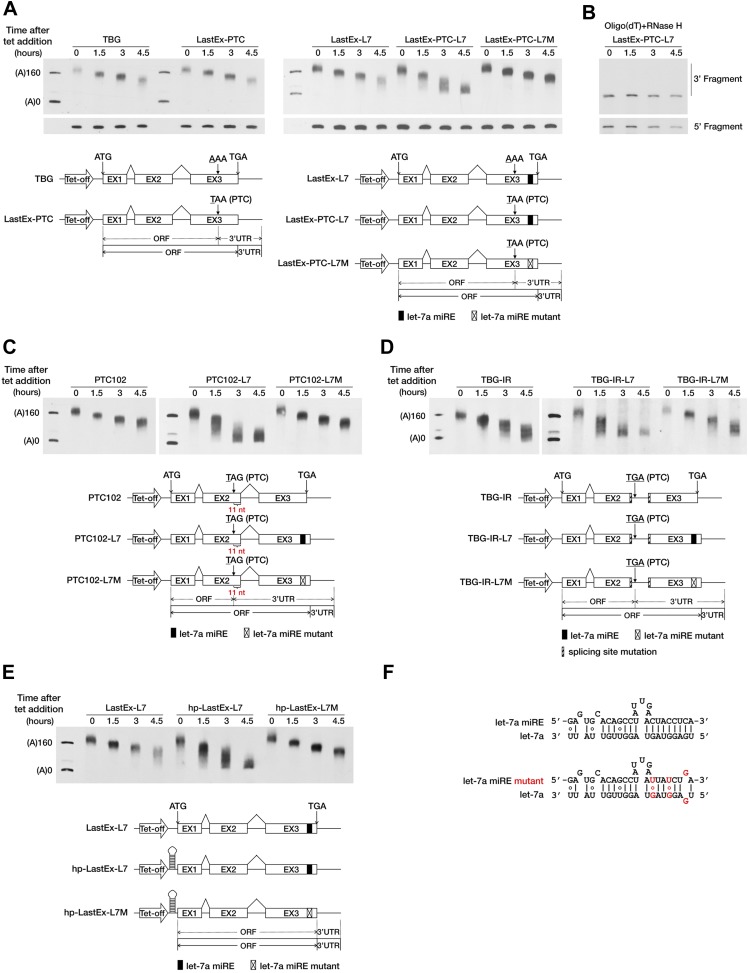
A PTC potentiates rapid miRNA-mediated deadenylation of nonsense mRNAs.(A) The influence of a PTC on BG mRNAs with or without a downstream miRE. Cytoplasmic RNA was collected at the indicated times after transcriptional arrest by adding tetracycline (tet). The RNA samples were then treated with RNase H and an oligodeoxynucleotide complementary to codons 74–81 of BG mRNA to generate 5′ and 3′ fragments, which were then separated by electrophoresis on a denaturing polyacrylamide gel and detected by Northern blotting. Left panel: BG mRNA deadenylation with or without a PTC in the last exon. TBG contains an intact BG ORF. A PTC was introduced into TBG at codon 121 within the last exon to generate LastEx-PTC. Both constructs harbor no miRE in their ORFs. Right panel: the influence of let-7a on the deadenylation rate of BG mRNAs harboring one let-7a miRE in its ORF with or without an upstream PTC mutation. LastEx-L7 contains one let-7a miRE in the last exon of the BG ORF. LastEx-PTC-L7 has a PTC at the same position as LastEx-PTC, which is 16 nt upstream of the let-7a miRE. Two nucleotides within LastEx-PTC-L7 let-7a miRE seed were changed to create a synonymous codon in LastEx-PTC-L7M. The positions of the ORF start site and original stop codon are indicated by arrows. The borders of the original ORF/3′ UTR and redefined ORF/3′ UTR upon PTC mutation are indicated by solid or dashed lines below the constructs. Markers A(0) and A(160) correspond in size to BG mRNA 3′ fragments bearing no poly(A) or a 160-nt poly(A) tail, respectively. (B) Confirmation of poly(A) tail shortening by treatment with oligo(dT) and RNase H. The same LastEx-PTC-L7 RNA as in A were further treated with oligo(dT) and RNase H and analyzed by Northern blotting. (C) Induction by let-7a of accelerated deadenylation of nonsense BG mRNAs that do not conform to the ‘50 nt boundary rule’ of EJC-NMD. PTC102-L7 contains a PTC mutation 11 nt upstream of the last exon–exon junction and a let-7a miRE in the last exon of the ORF. PTC102-L7M is identical to PTC102-L7 except for a mutated let-7a miRE. PTC102 contains the PTC only. (D) The influence of let-7a on the deadenylation rate of BG mRNAs harboring one let-7a miRE in its ORF with a retained last intron. TBG-IR-L7 contains one let-7a miRE in the last exon of the BG ORF and a retained last intron that creates a PTC 505 nt upstream of the let-7a miRE. Two nucleotides within the TBG-IR-L7 let-7a miRE seed were mutated as in A. TBG-IR only has the retained intron but no miRE. (E) The influence of let-7a on the deadenylation rate of BG mRNAs harboring one let-7a miRE in its ORF in the absence of translation. hp-LastEx-L7 contains a 40-nt inverted repeat in its 5′ UTR to block translation initiation. hp-LastEx-L7M is identical to hp-LastEx-L7 except for a mutated let-7a miRE. (F) Duplexes expected for the let-7a miRE or its mutant counterpart base-paired with let-7a.